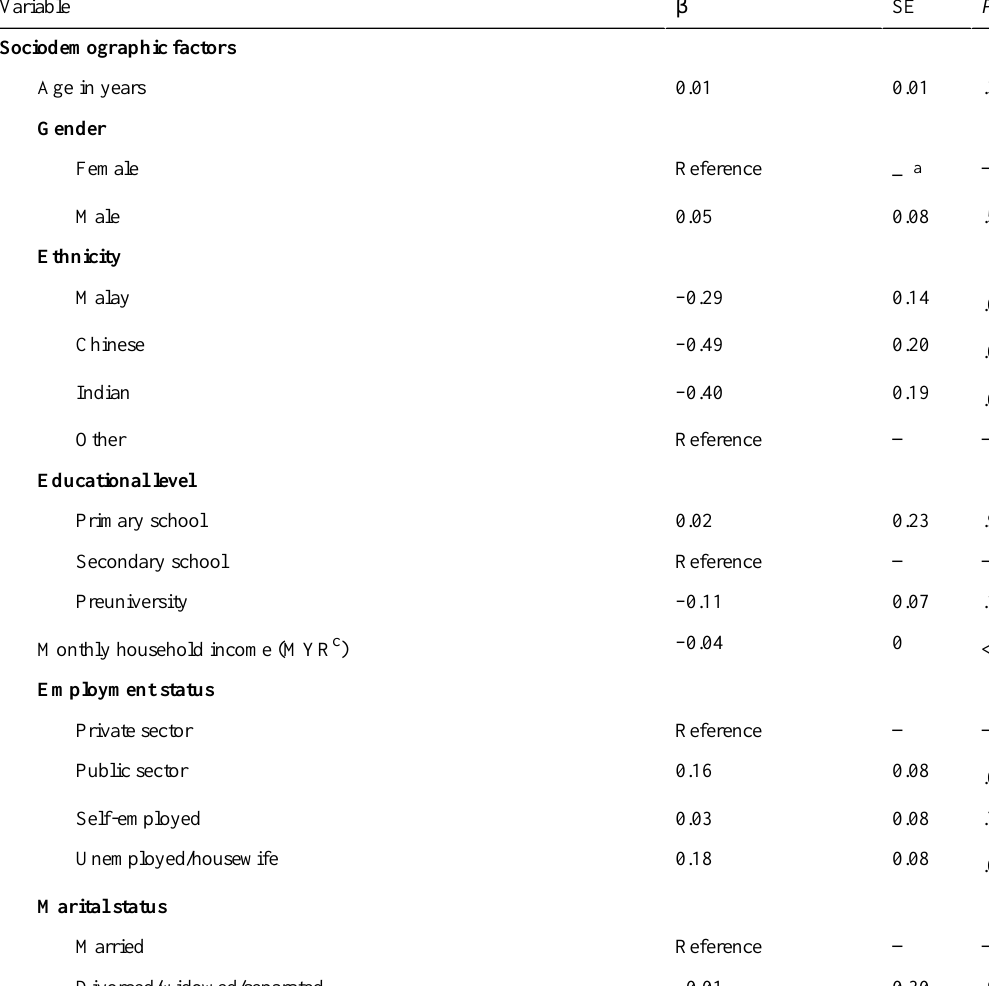
Table 3. Association between sociodemographic, parental, child-related, and environmental factors with parental barriers